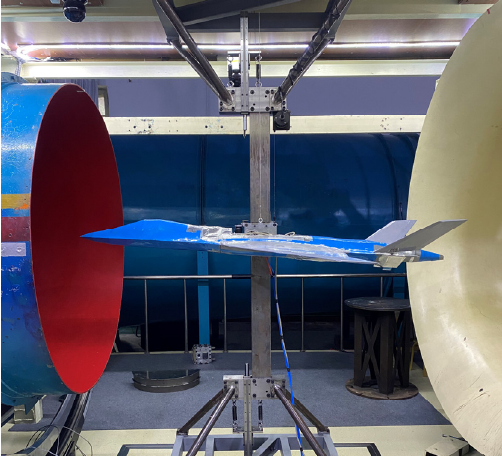
Figure 22. The full model aircraft assembled in the wind tunnel test section.